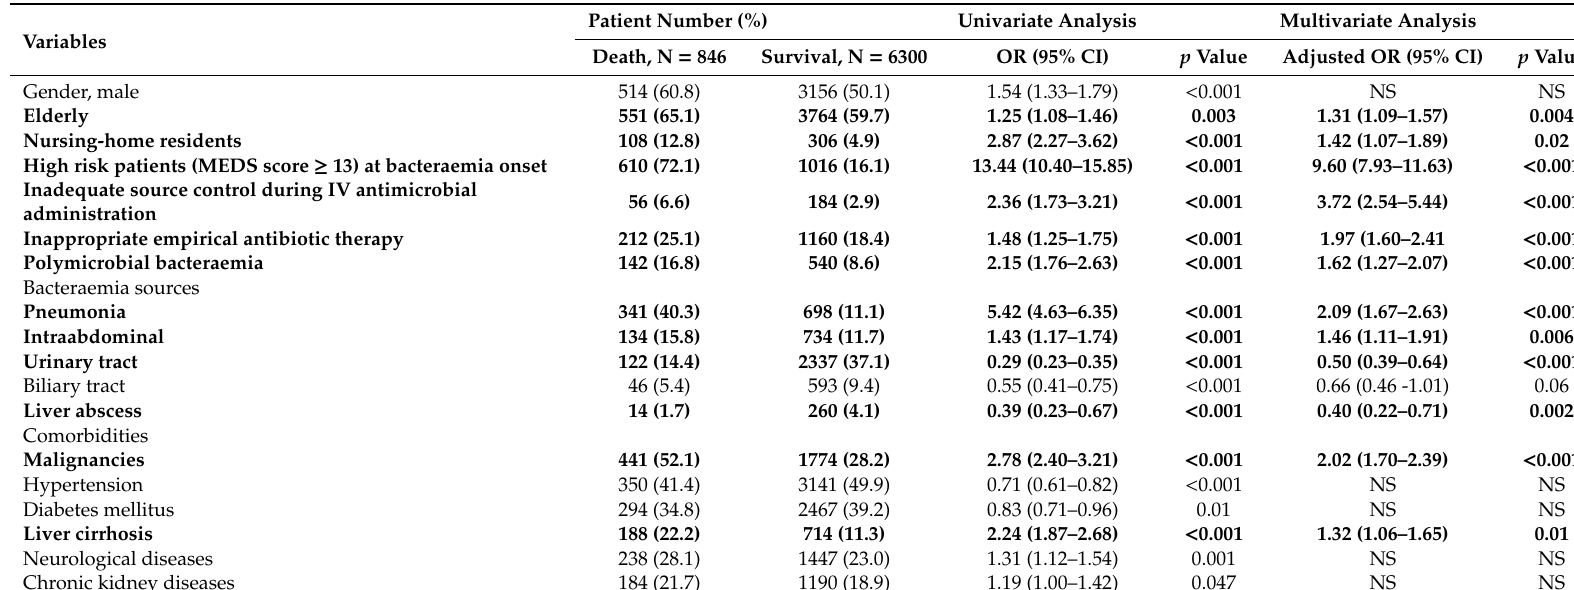
Table 2. Risk factors of 30-day crude mortality in a total of 7146